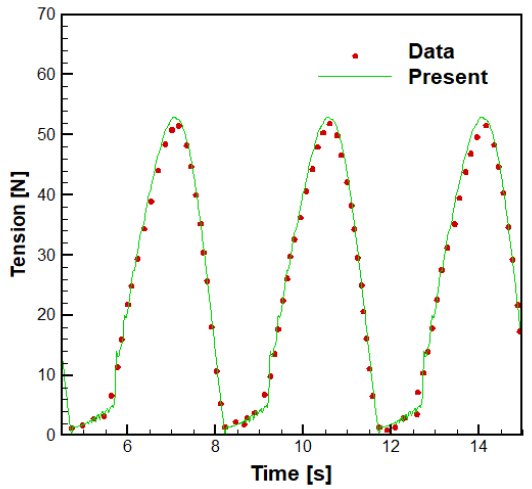
Figure 7. Dynamic load of the mooring line.